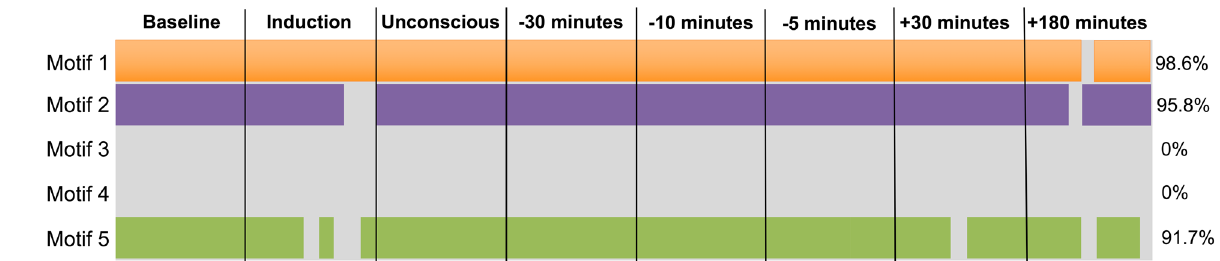
Figure 3. Motif significance across epochs and participants . For each motif, the total aggregate frequency of motifs in the network was calculated by summing across all channels. A z-score was calculated for the frequency of each motif in each network by comparing the total number of motifs in a given network to the distribution of motif frequency in 100 null networks. Motifs that were statistically significance per participant and time point are represented by orange (motif 1), purple (motif 2) and green (motif 5) rectangles. Motifs not statistically significant are left grey. Motif significance varied across time points and participants. Percentages in the right column represent the frequency of motif significance. A motif significance of 98.6% indicates that this motif was significant throughout all participants and time points, except one participant, at one time